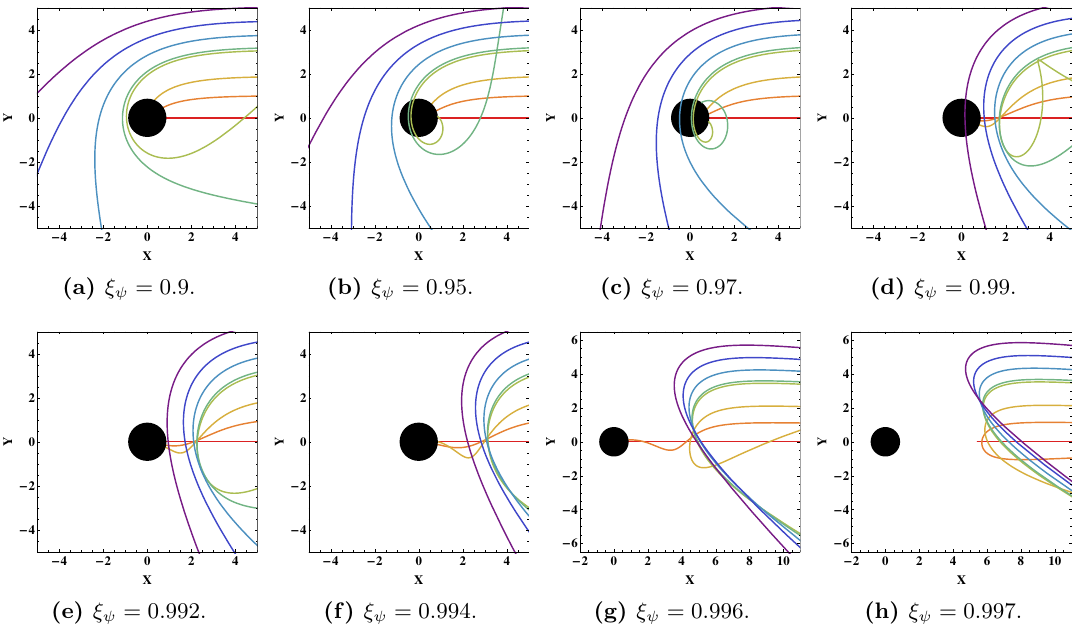
Figure 3 . Propagation of photon with di(cid:11)erent (cid:24) in the rotating squashed KK black